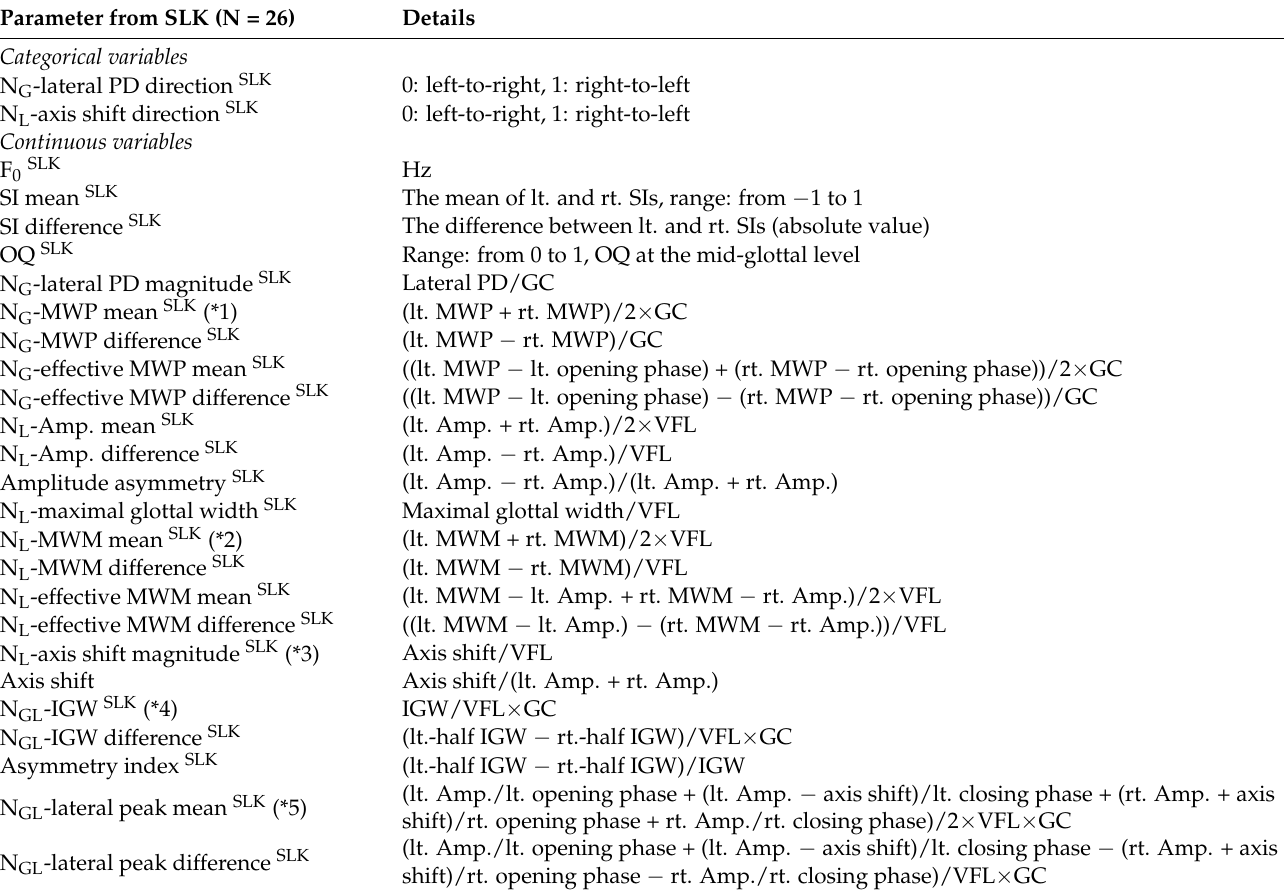
Table 4. Parameters from digital kymography (DKG) 1: Single-line kymography